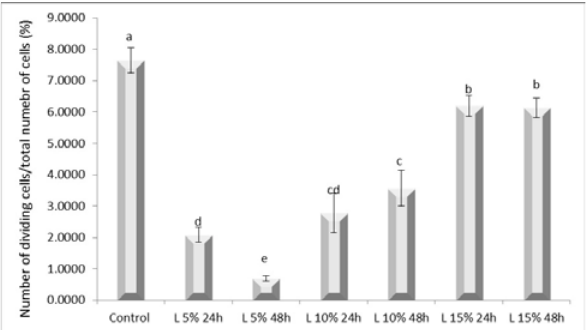
Figure 2. The influence of L. sibirica extracts on the mitotic index in root meristem cells of Allium cepa L. (The data are the averages ± SE of three repetitions; a, b, c, d, e, - the interpretation of statistical significance and of significant differences through the Duncan test, p <0.05).